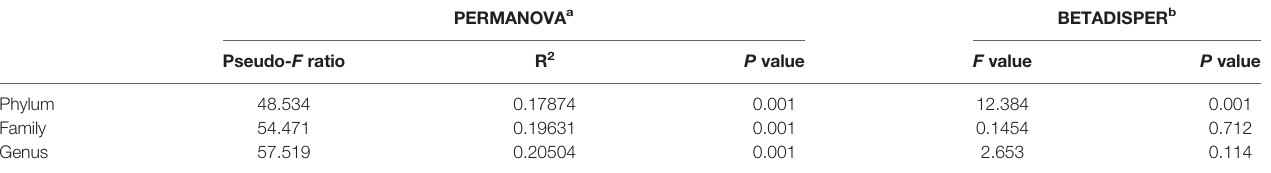
TABLE 3 | Permutation analysis of variance and analysis of multivariate homogeneity of group dispersions on Bray-Curtis distances of DD negative and DD positive skin microbiota grouped at different taxonomic levels.